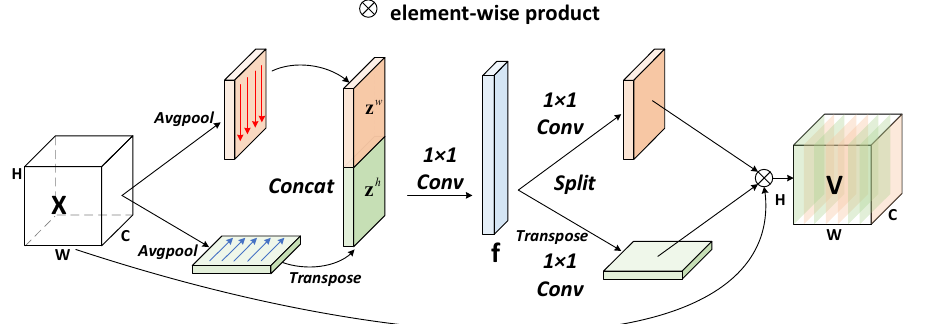
Figure 3. Coordinate attention.